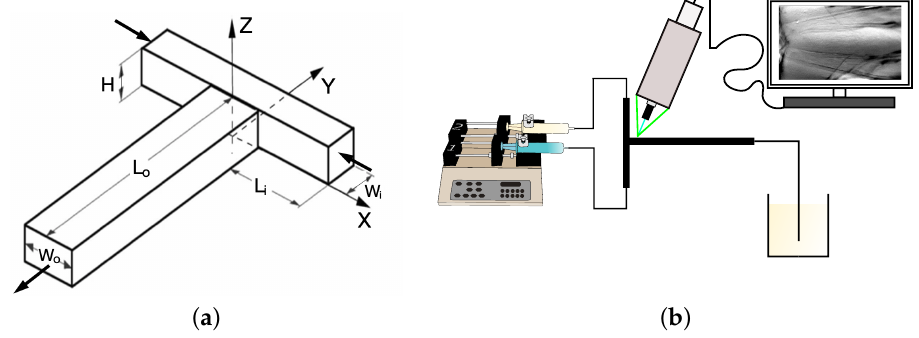
Figure 1. ( a ) Sketch of the T-reactor geometry and reference system; ( b ) experimental